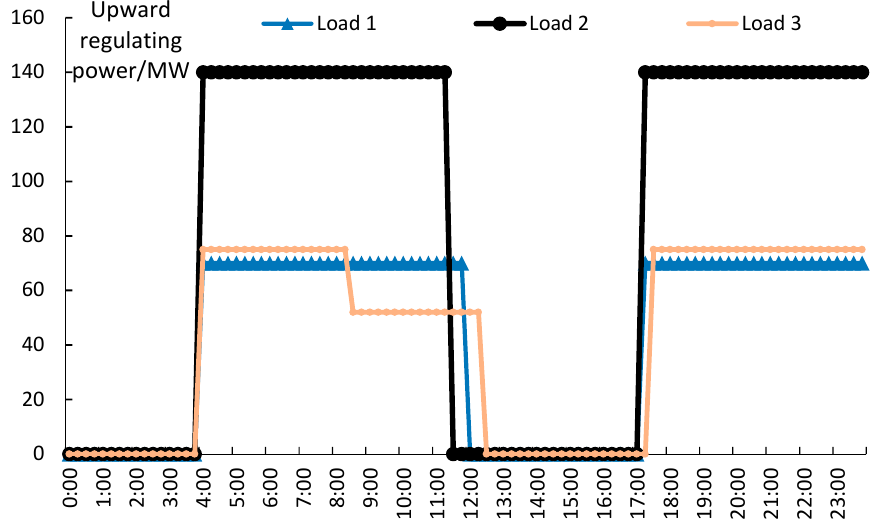
Figure A1. Regulation of energy-intensive loads in Mode 1.